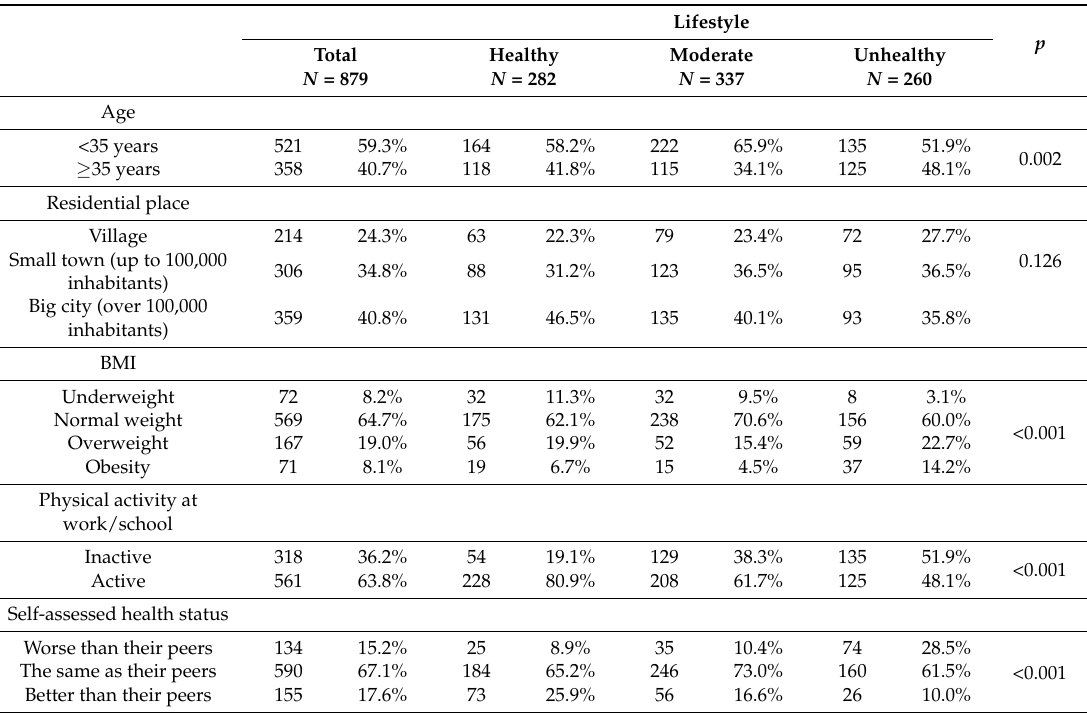
Table 1. Characteristics of study sample including lifestyle